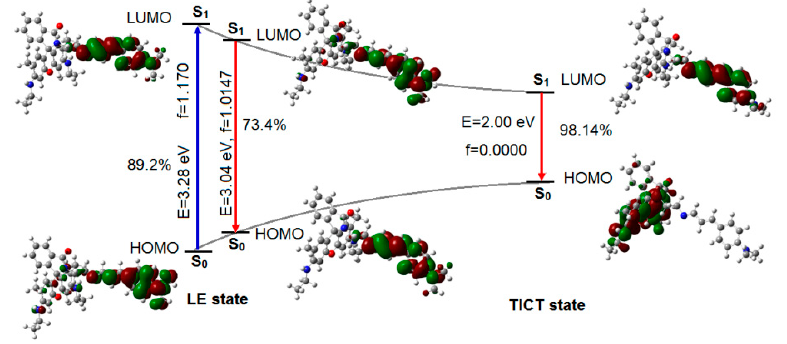
Figure 3. ( a ) The optimized geometry of RLED at the B3LYP/LanL2DZ level of theory. ( b ) The topological properties of RLED at the bond critical points (BCPs) and the ring critical point (RCPs): the red points denote bond critical points (BCPs) and the yellow points denote ring critical points (RCPs).